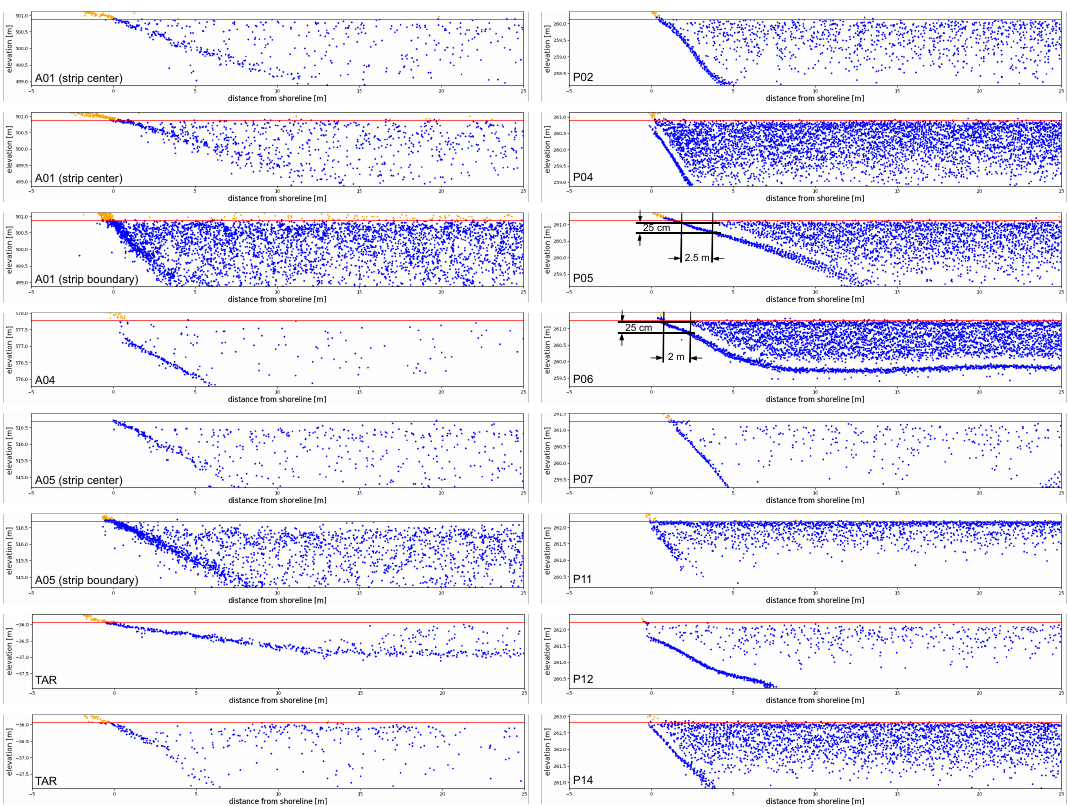
Figure 8. Selected vertical sections; Left column : Single Photon LiDAR (Navarra: A01–A05, Easton: TAR); Right column : Topo-Bathymetric Multi-Photon LiDAR; blue: water candidate points, orange: points on dry land, red line: estimated water level. Section width: 30m, section depth: 3m, height range: